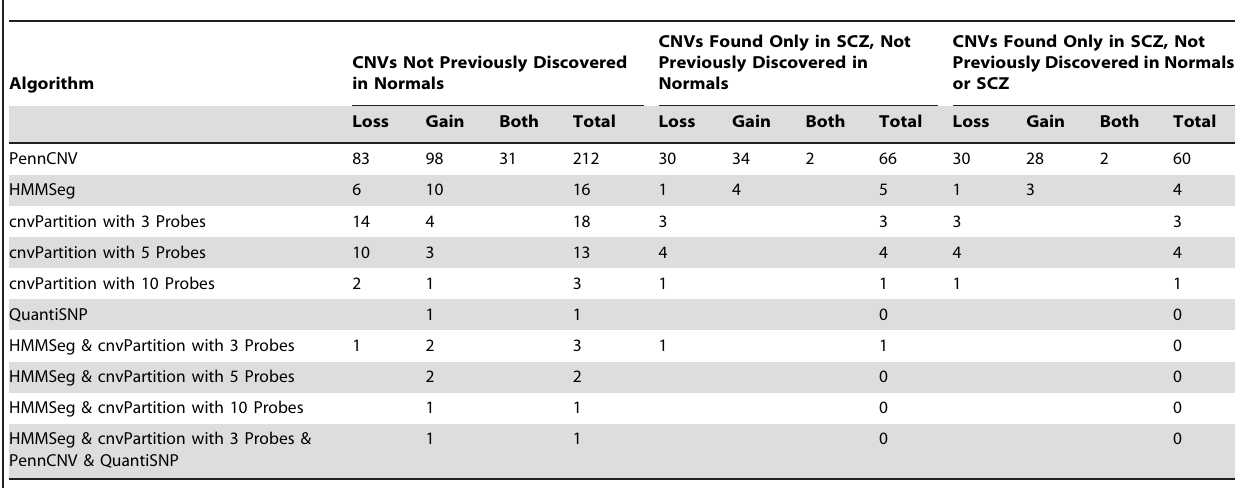
Table 6. ‘‘Newly discovered’’ CNVs detected by each algorithm based on 48 normal and 48 schizophrenia subjects, using the ‘‘40% either’’ overlap